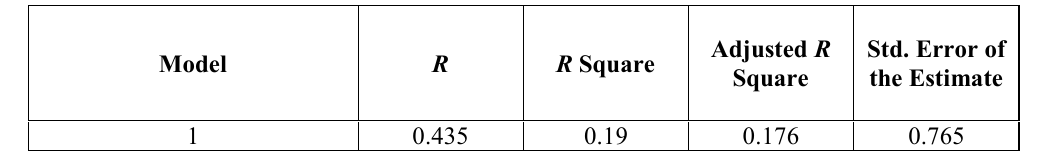
Table 7. The Summary Table